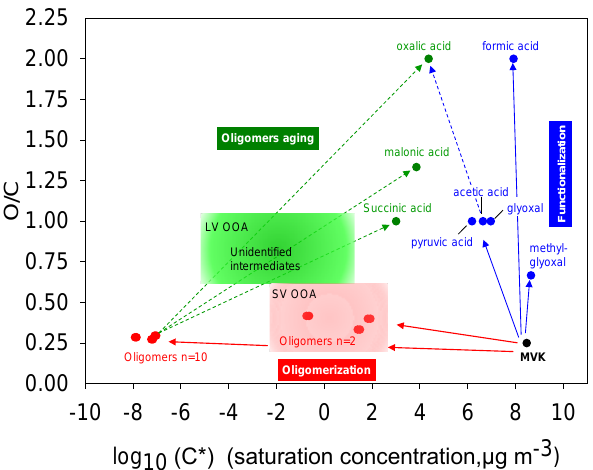
Figure 11. Potential atmospheric fate of MVK in the aqueous phase. The x axis denotes volatility (log10 of C* at 298K); the y axis de- notes oxidation state, approximated by O / C (Jimenez et al.,